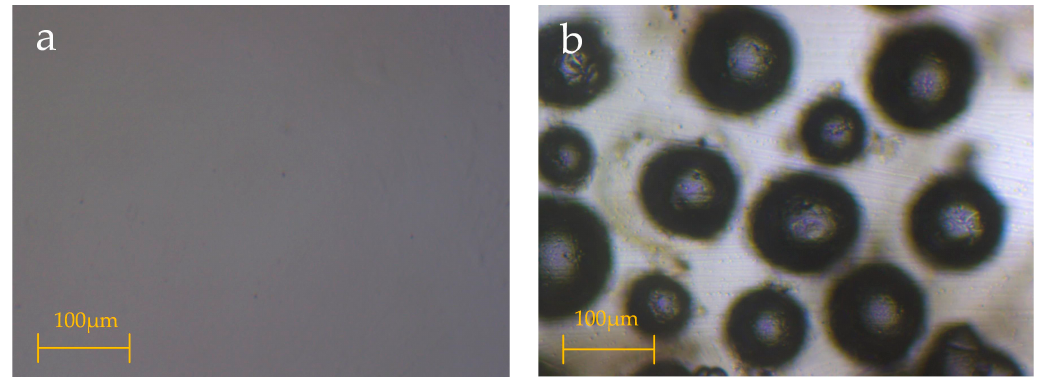
Figure 1. Morphology of epoxy resin samples. ( a ) Pure epoxy resin. ( b ) Microcapsule/epoxy resin composite.